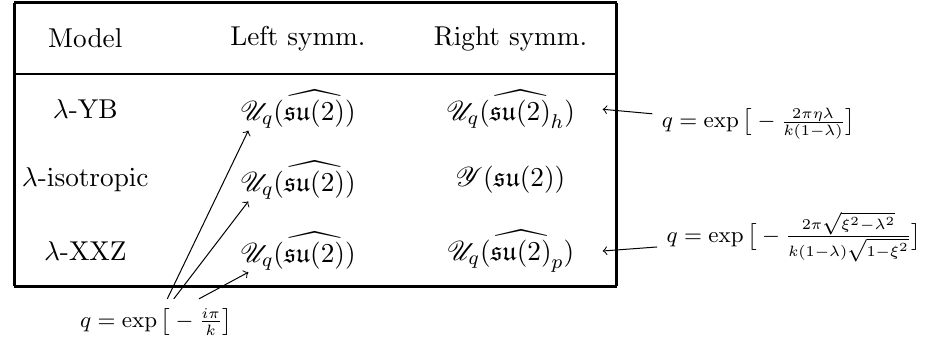
Table 2 . The symmetries of the lambda models. Here, \left" and \right" refer to the relation with the sigma model symmetries in the sigma model limit k ! 1